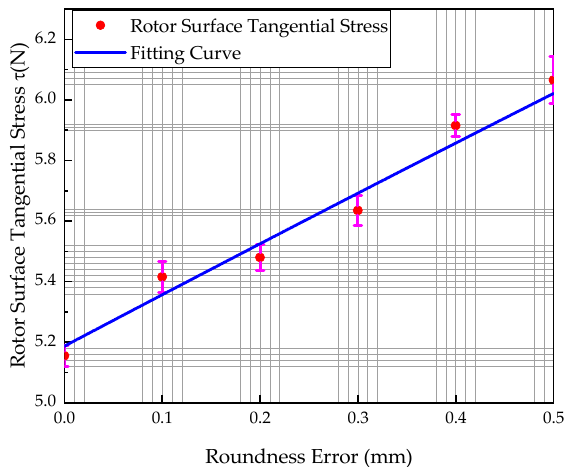
Figure 16. Roundness error and tangential stress fitting curve at 36,000 r/min.